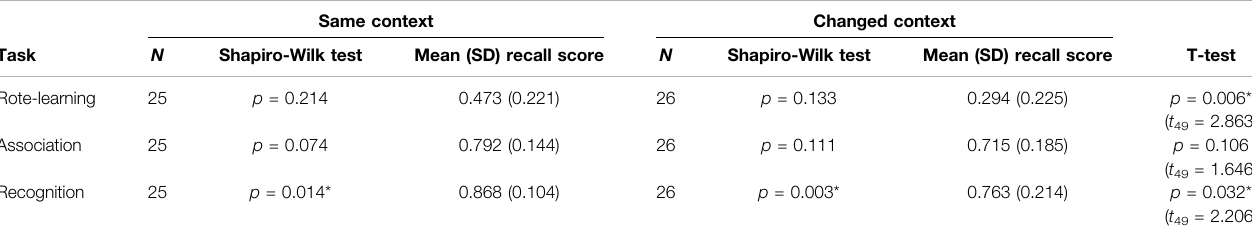
TABLE 6 | Comparison through independent samples Student ’ s t -test ( p -values with t -statistic and degrees of freedom reported) of mean recall scores between context- changed and context-unchanged sub-samples, separated by memory task. Same